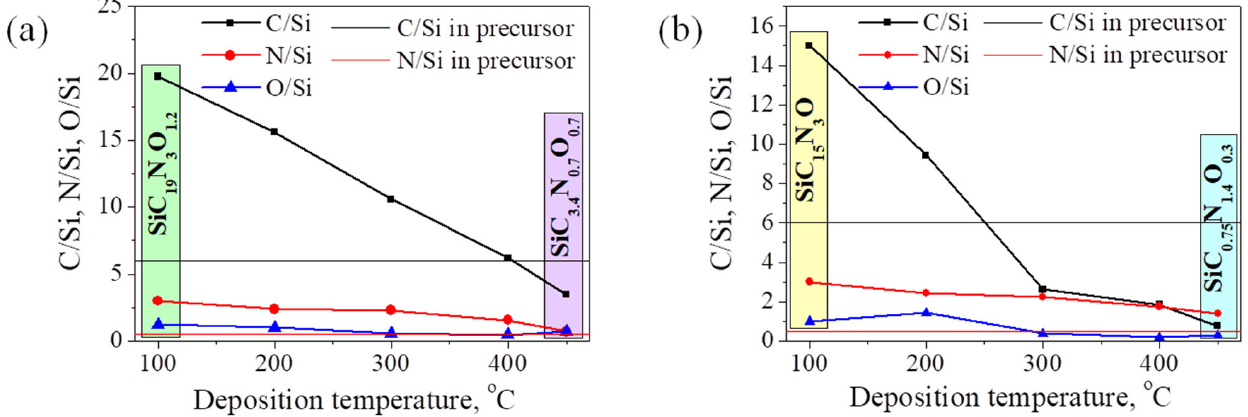
Figure 4. Elemental composition of SiCN films deposited using BTMSPA/He ( a ) or BTMSPA/NH 3 ( b ) mixtures.